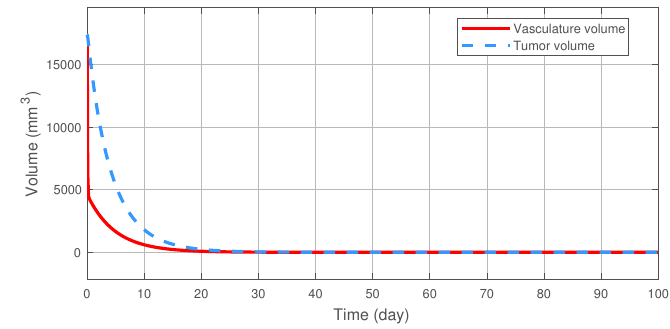
Figure 5. The reduction of the tumor volume.